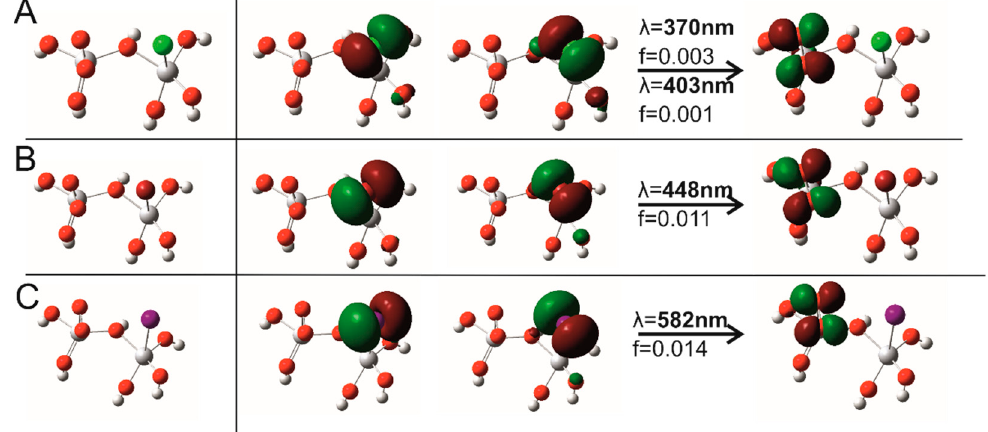
Figure 6. The simplified vacancy model (left) used for TD-DFT calculations, optimized with Cl − ( A ), Br − ( B ) and I − ( C ) anions, respectively, and leading transitions in the long wavelength region of absorption with the wavelength and the oscillator strength shown (right).